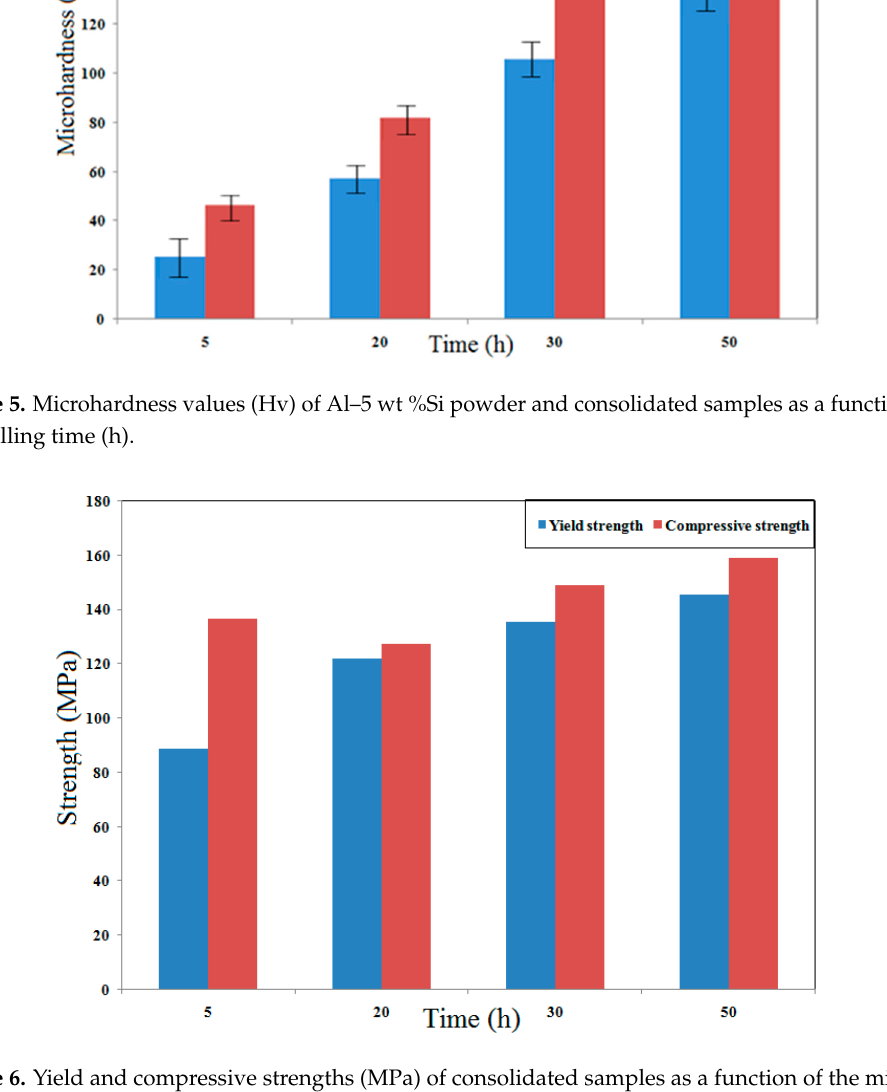
Figure 6. Yield and compressive strengths (MPa) of consolidated samples as a function of the milling time (h).